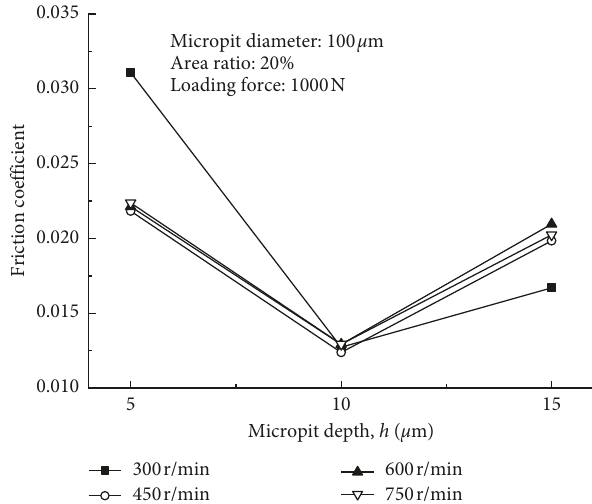
Figure 6: Friction coefficient when the value of the area ratio is